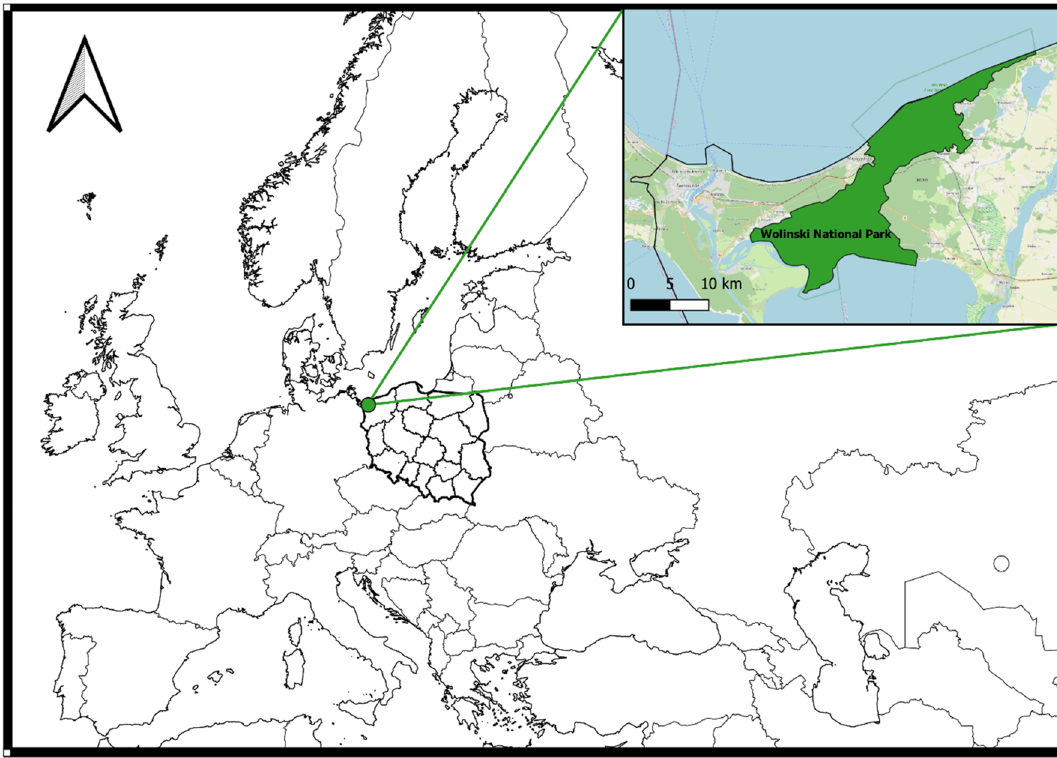
Figure 1. The location of the Wolinski National Park in Europe. (QGIS 3.10; https ://qgis.org/pl/site/forus ers/ downl